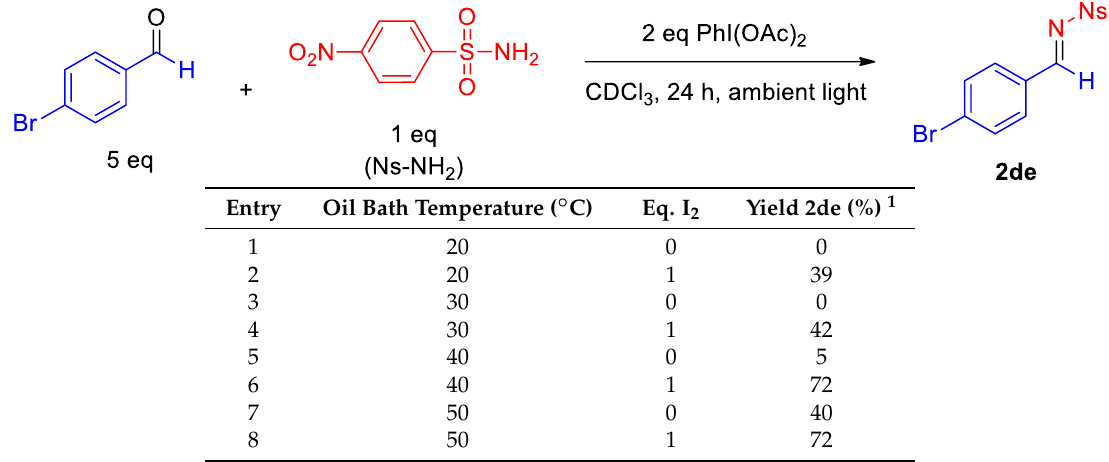
Table 3 . Temperature dependence of the PhI(OAc) 2 -promoted N -sulfonyl imine formation in the presence (and absence) of I 2 .